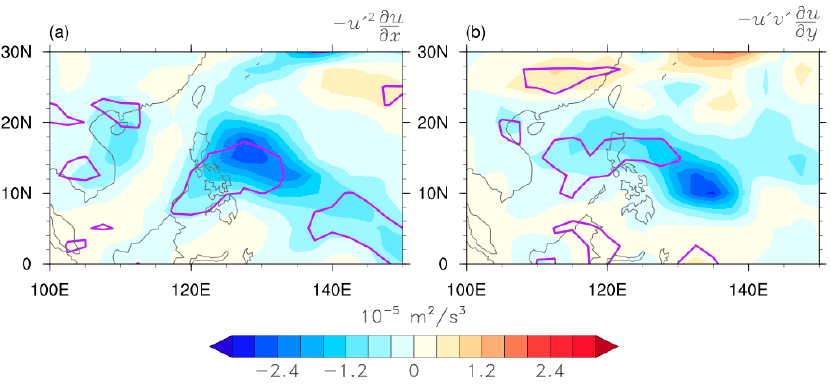
Figure 5. Difference in subterms of the barotropic process: ( a ) CK 1 ; and ( b ) CK 3 at 850 hPa between Pos_year and Neg_year, in units of m 2 /s 3 ; purple contours indicate p -value of 0.05.